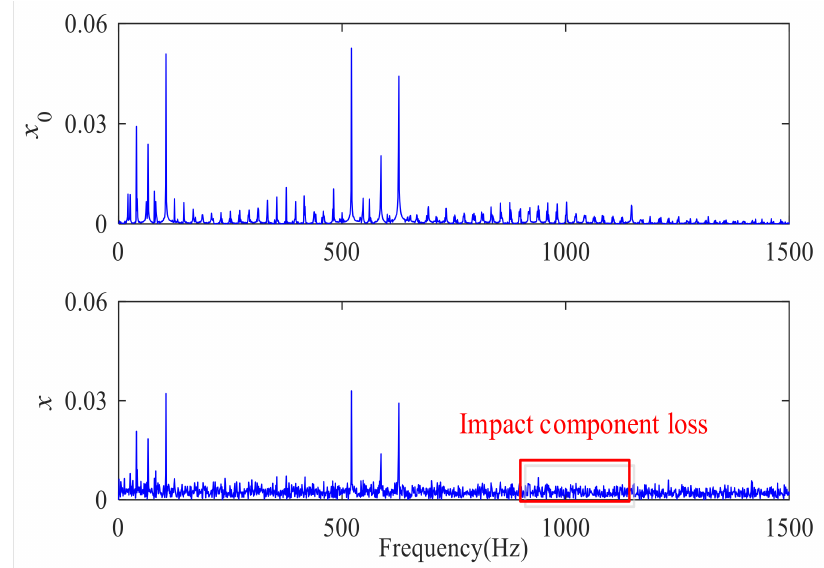
Figure 5. The envelope spectrums of the constructed simulation